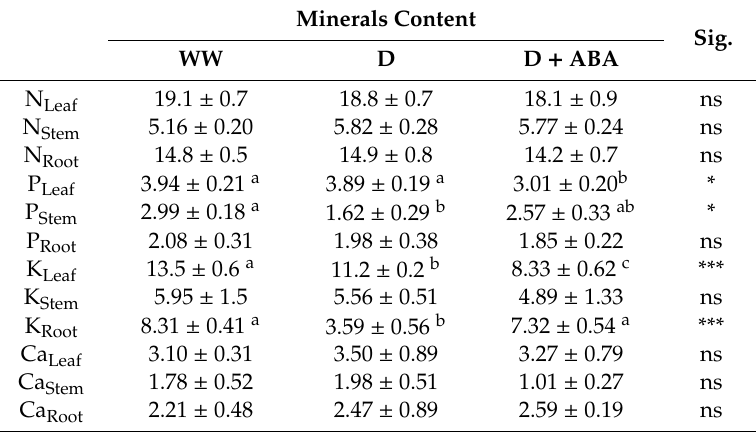
Table 3. Minerals content (g kg − 1 DW for macronutrients, and mg kg − 1 DW for micronutrients) in the di ff erent plant organs of well-watered (WW) and droughted without (D) and with abscisic acid (D + ABA) plants at the end of the